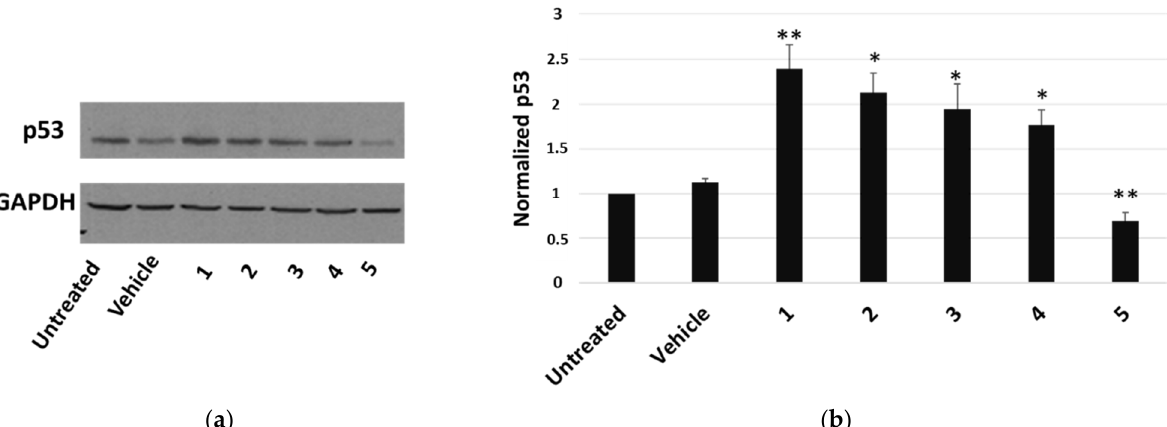
Figure 4. Western blot analysis of p53 expression in HepG2 cells. ( a ) Representative Western blot on 50 μ g of total proteins from cells treated for 24 h with 1 μ M of each compound or vehicle only. ( b ) Densitometric analysis relative to three independent Western blots. Protein levels are normalised with respect to GAPDH expression and reported as variation with respect to the untreated sample. Data are reported as mean ± SE of three experiments. Statistical analysis was performed using the Student’s t -test. * p < 0.05, ** p < 0.01 vs. vehicle-treated cells.